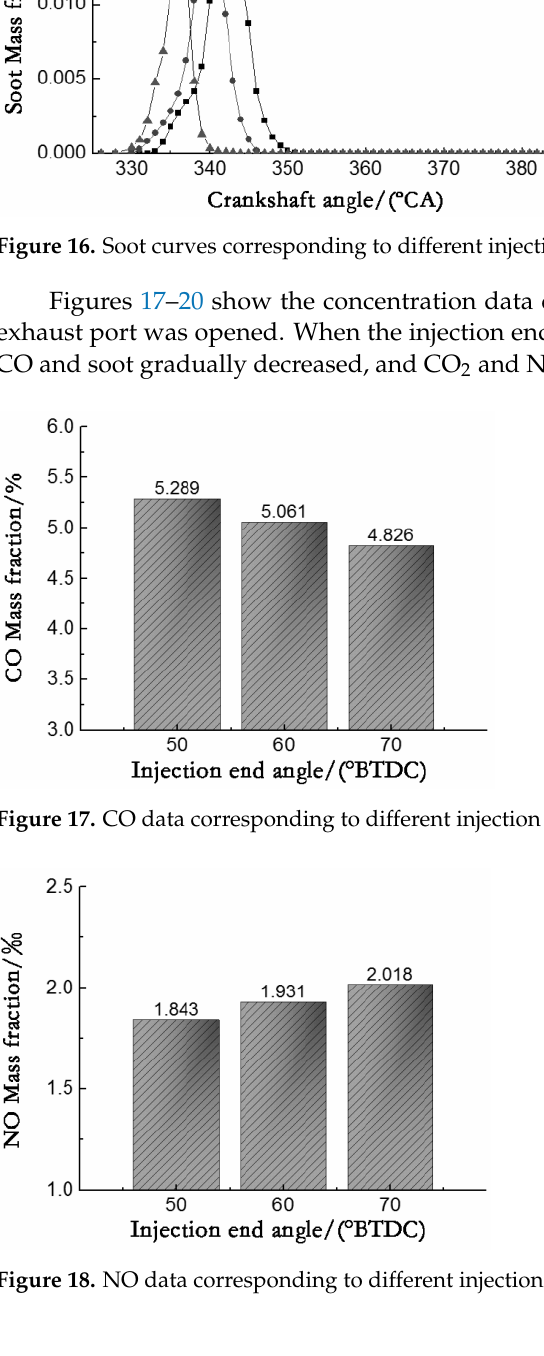
Figure 15. NO curves corresponding to different injection end angles.